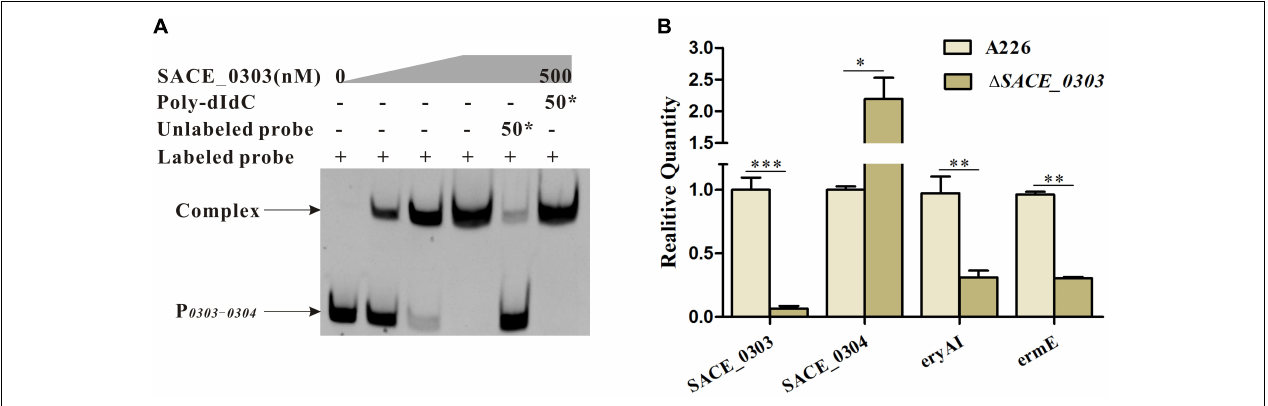
FIGURE 2 | Regulatory mode of SACE_0303 in SACE_0303 and SACE_0304. (A) EMSAs of the interaction of probe P 0303 − 0304 with purified His 6 -SACE_0303 protein. (B) Effects of SACE_0303 disruption on transcripts of SACE_0303 , SACE_0304 , eryAI , and ermE . RT-qPCR was used to quantify the amounts of transcripts in A226 and (cid:49) SACE_0303 cultured for 24 h in the liquid R5 medium. Error bars (B) : SD from triplicate experiments. Statistical notations (B) : ∗ p < 0.05, ∗∗ p < 0.01, ∗∗∗ p < 0.001.